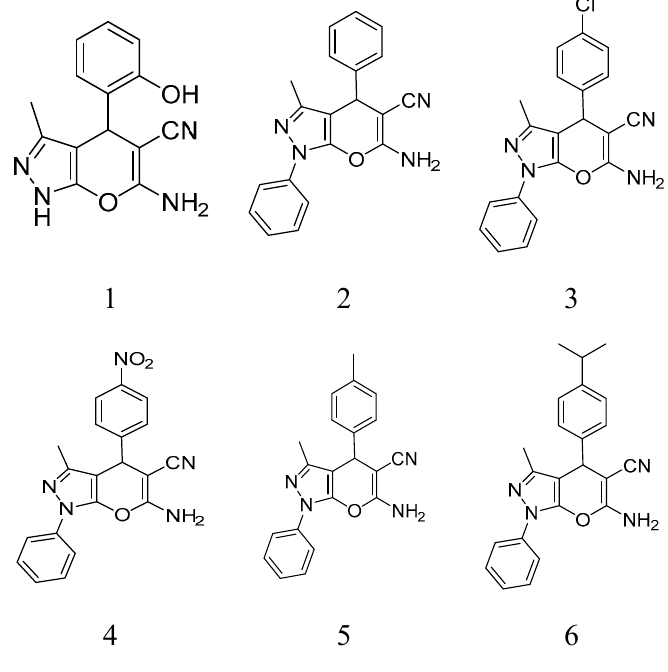
Figure 1. Structure of compounds